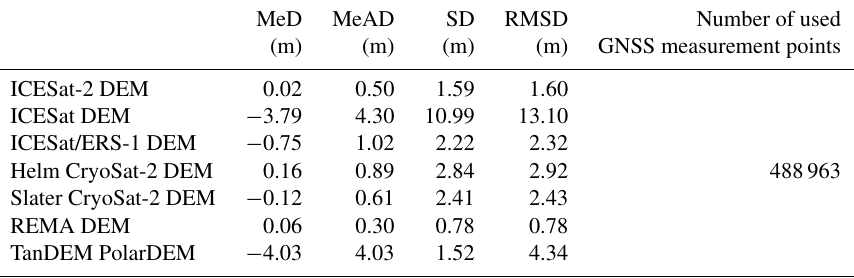
Table 7. Comparisons between the ICESat-2 DEM, ICESat DEM, ICESat/ERS-1 DEM, Helm CryoSat-2 DEM, Slater CryoSat-2 DEM, REMA DEM, TanDEM PolarDEM and GNSS elevation data in areas of low elevation change from 2001 to 2015. MeD MeAD SD RMSD Number of used (m) (m) (m) (m) GNSS measurement points ICESat-2 DEM